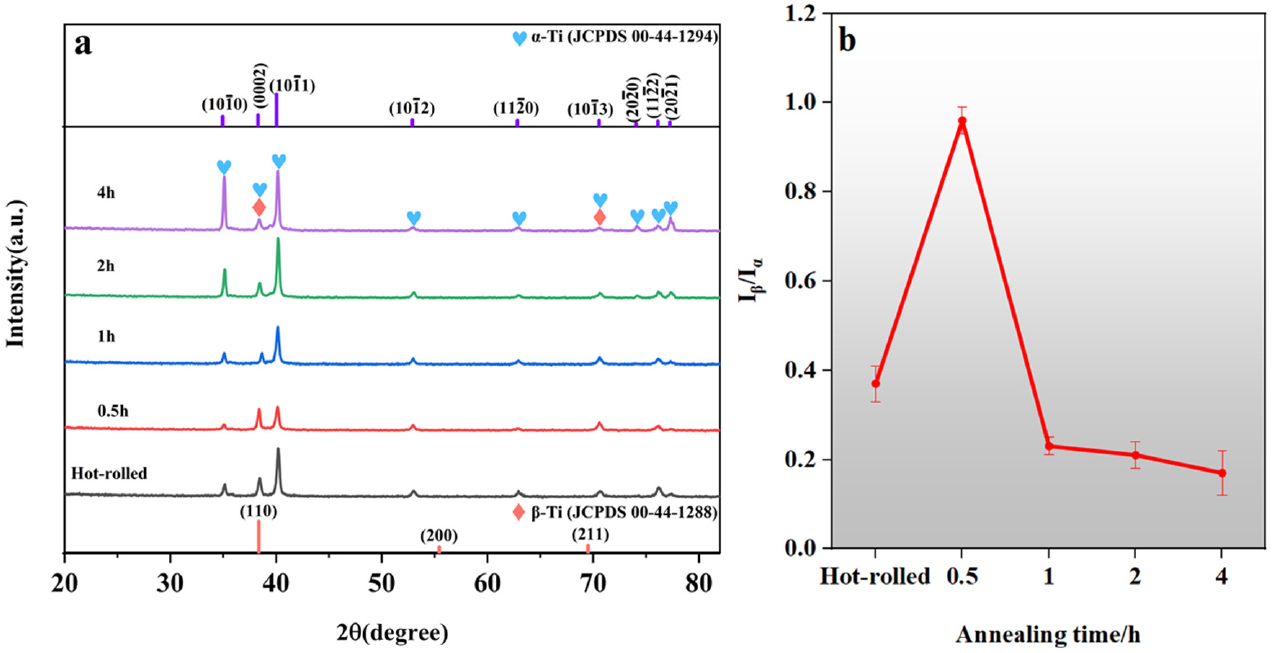
Figure 7. XRD results of TA10 annealed sheets: ( a ) XRD patterns; ( b ) the peak intensity ratio I β /I α .